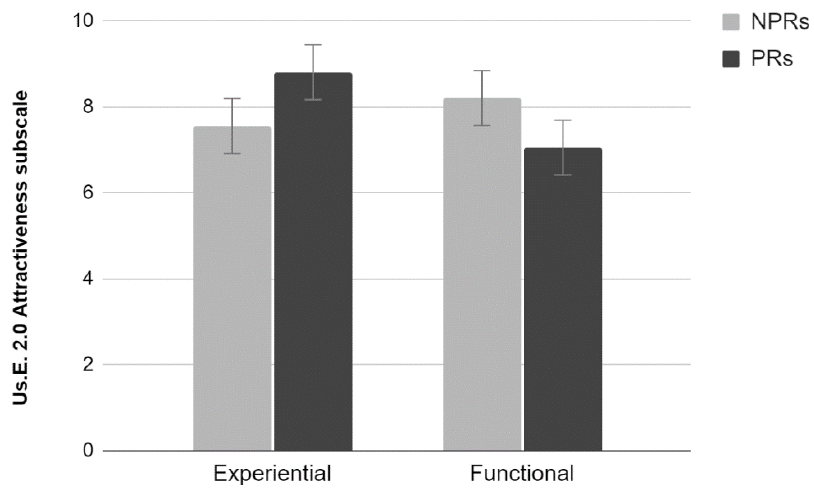
Figure 8. Us.E. 2.0 Attractiveness subscale score by Experience (NPRs vs. PRs) and Test (Experiential vs. Functional). Error bars denote 0.95 confidence intervals.